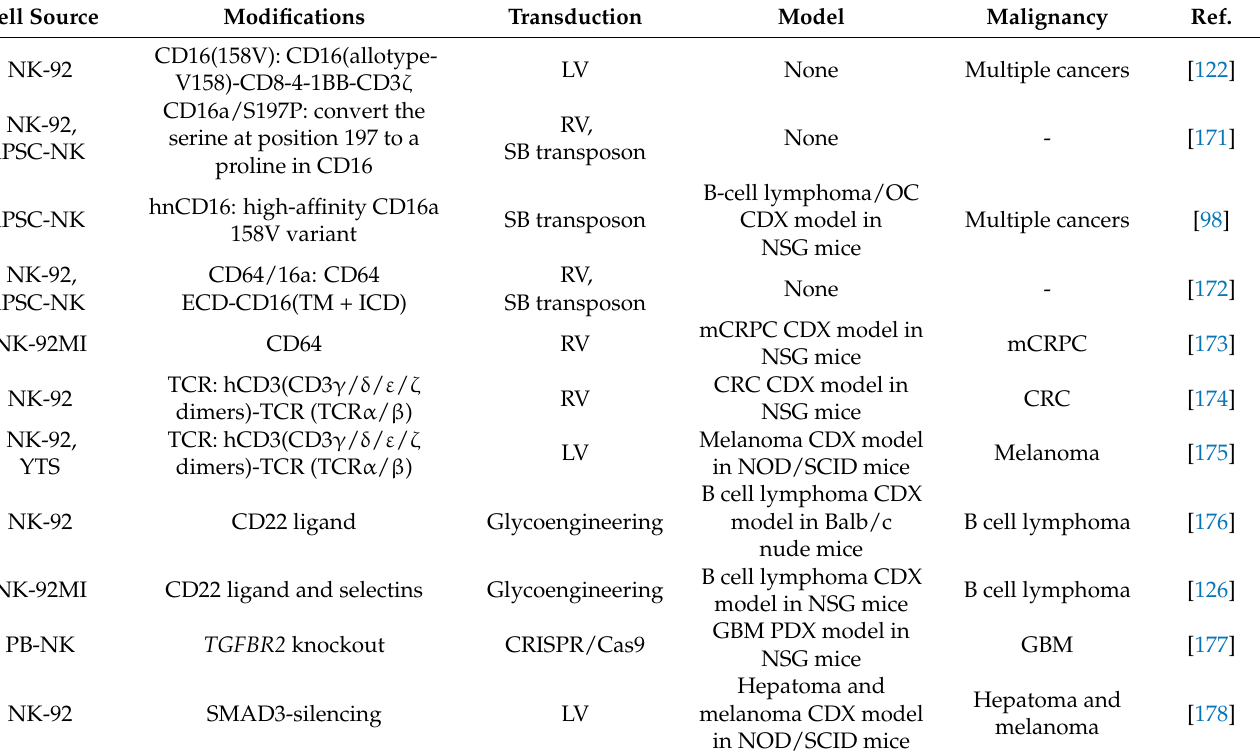
Table 2. Current genetic engineering strategies aimed at improving the functions of NK